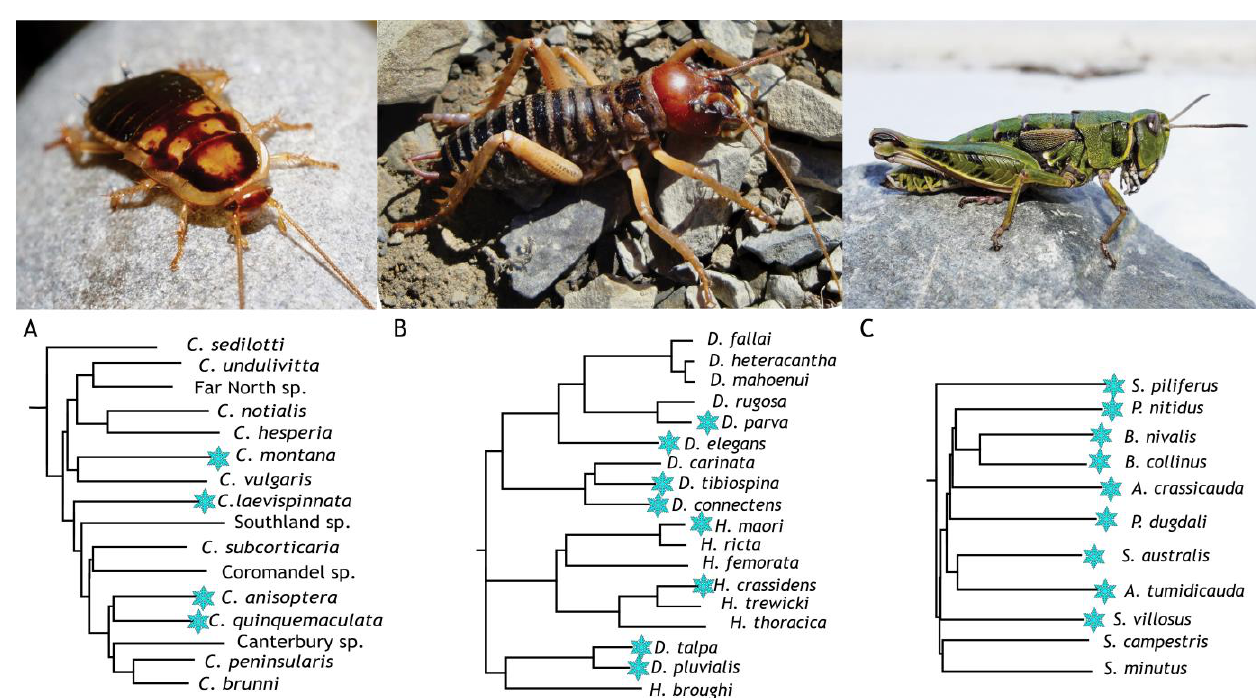
Figure 5. Three freeze-tolerant endemic Aotearoa-New Zealand insect species and their phylogenetic relatives. ( A ) The Otago alpine cockroach ( Celatoblatta quinquemaculata ) is a nocturnal omnivore. Alpine lineages are not monophyletic within New Zealand Celatoblatta (denoted with blue star on tree). ( B ) The mountain tree wētā ( Hemideina maori ) is a nocturnal omnivore. Alpine lineages are not monophyletic within the wētā clade. ( C ) The southern alpine grasshopper ( Sigaus australis ) is a diurnal herbivore within a cold-adapted endemic lineage. Phylogenetic relationships were reconstructed from ( A ) unpublished mtDNA genome sequences, ( B ) 755 transcriptomes [81], and ( C ) whole mtDNA genome sequences [82].